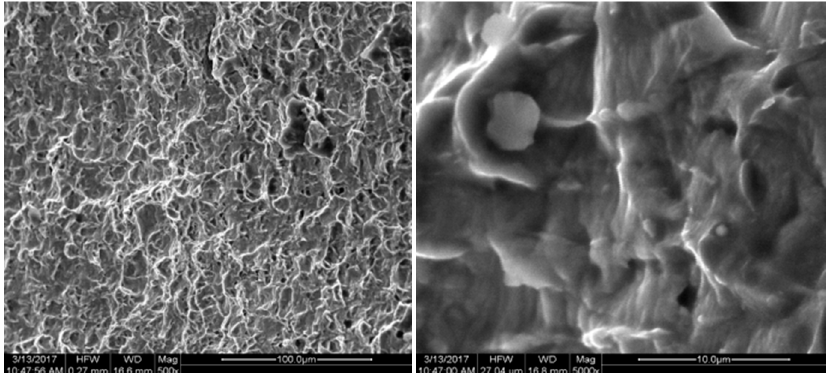
Figure 15. X-axis fracture under the tension speed of 20 μ m/min. Micromachines 2017 , 8 , 286